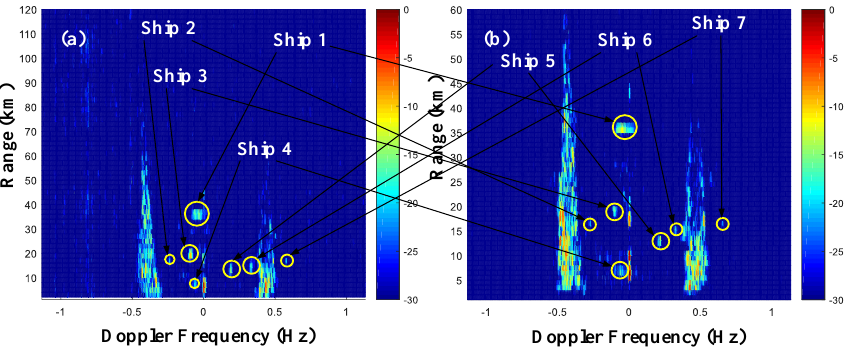
Figure 3. Two range-Doppler spectra collected using the Zhujiajian MHF radar at 10:40 a.m. on 28 August 2009. Seven ships are observed in both range-Doppler spectra. ( a ) 16.8 MHz; ( b ) 19.1 MHz.